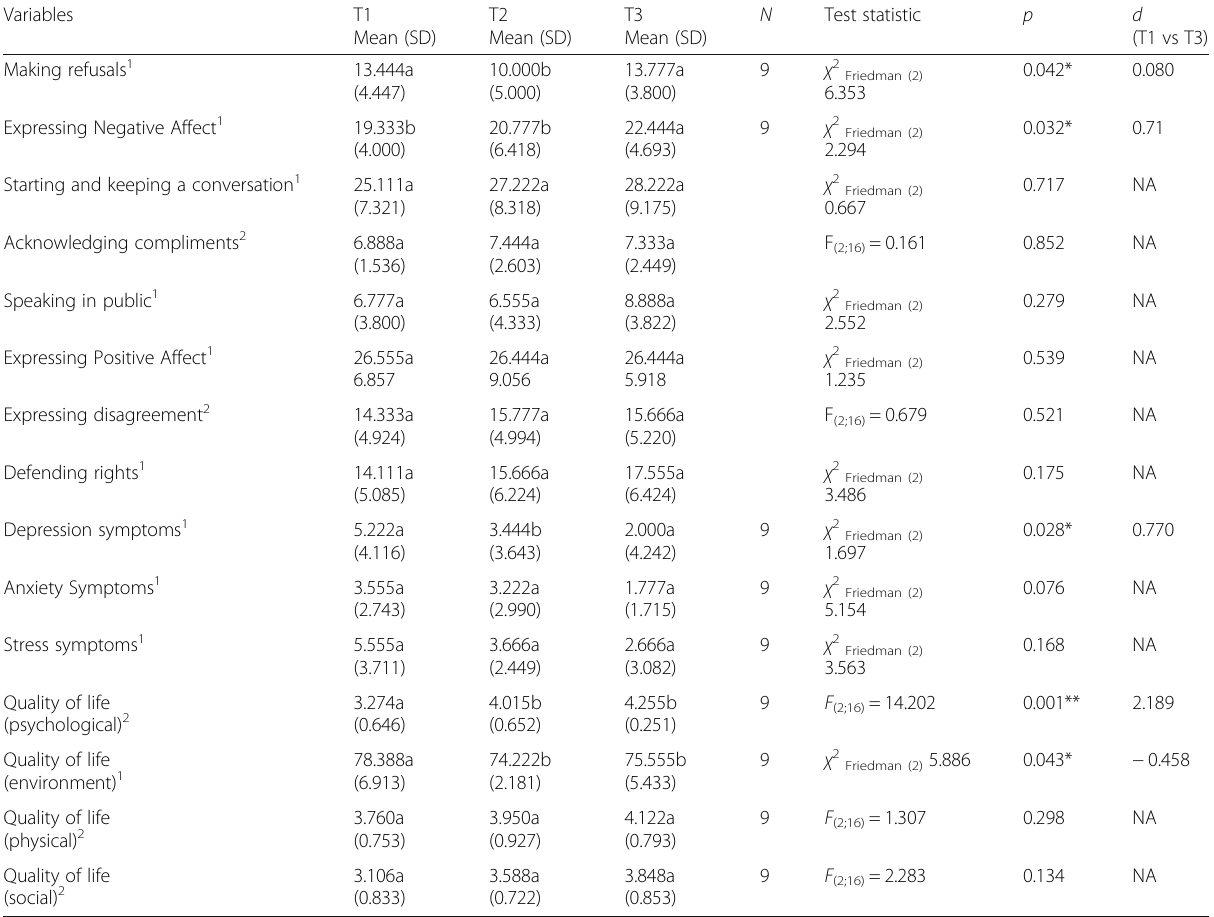
Table 1 Results of the intervention on social skills, depression, anxiety, stress, and quality of life